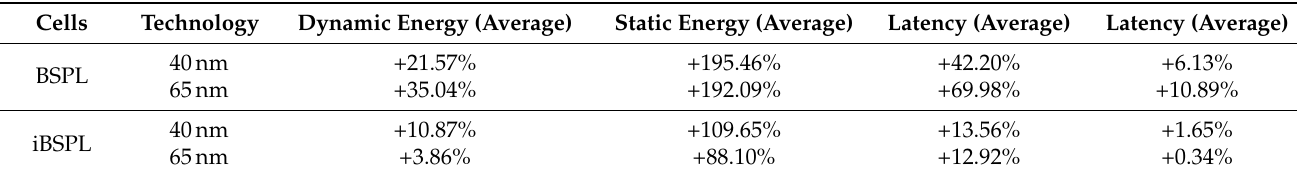
Table 6. Energy and latency overhead of the PRESENT SBox synthesized in BSPL and iBSPL cells compared to regular CMOS